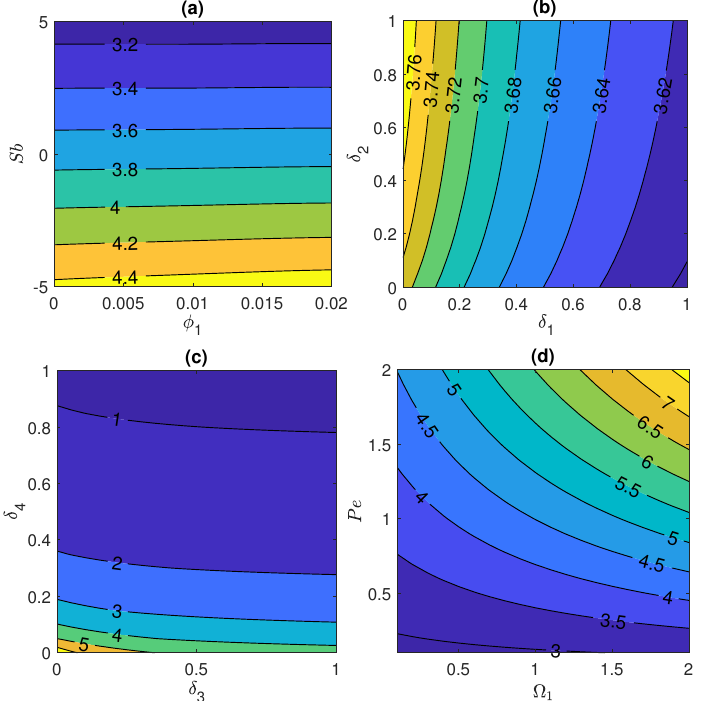
Figure 10. Motile micro-organism density number for ( a ) Stefan blowing Sb and initial volume fraction φ 1 , ( b ) velocity slip parameter δ 1 and thermal slip parameter δ 2 , ( c ) volume fraction slip parameter δ 3 and motile concentration slip parameter δ 4 and ( d ) concentration difference parameter Ω 1 and Peclet number Pe